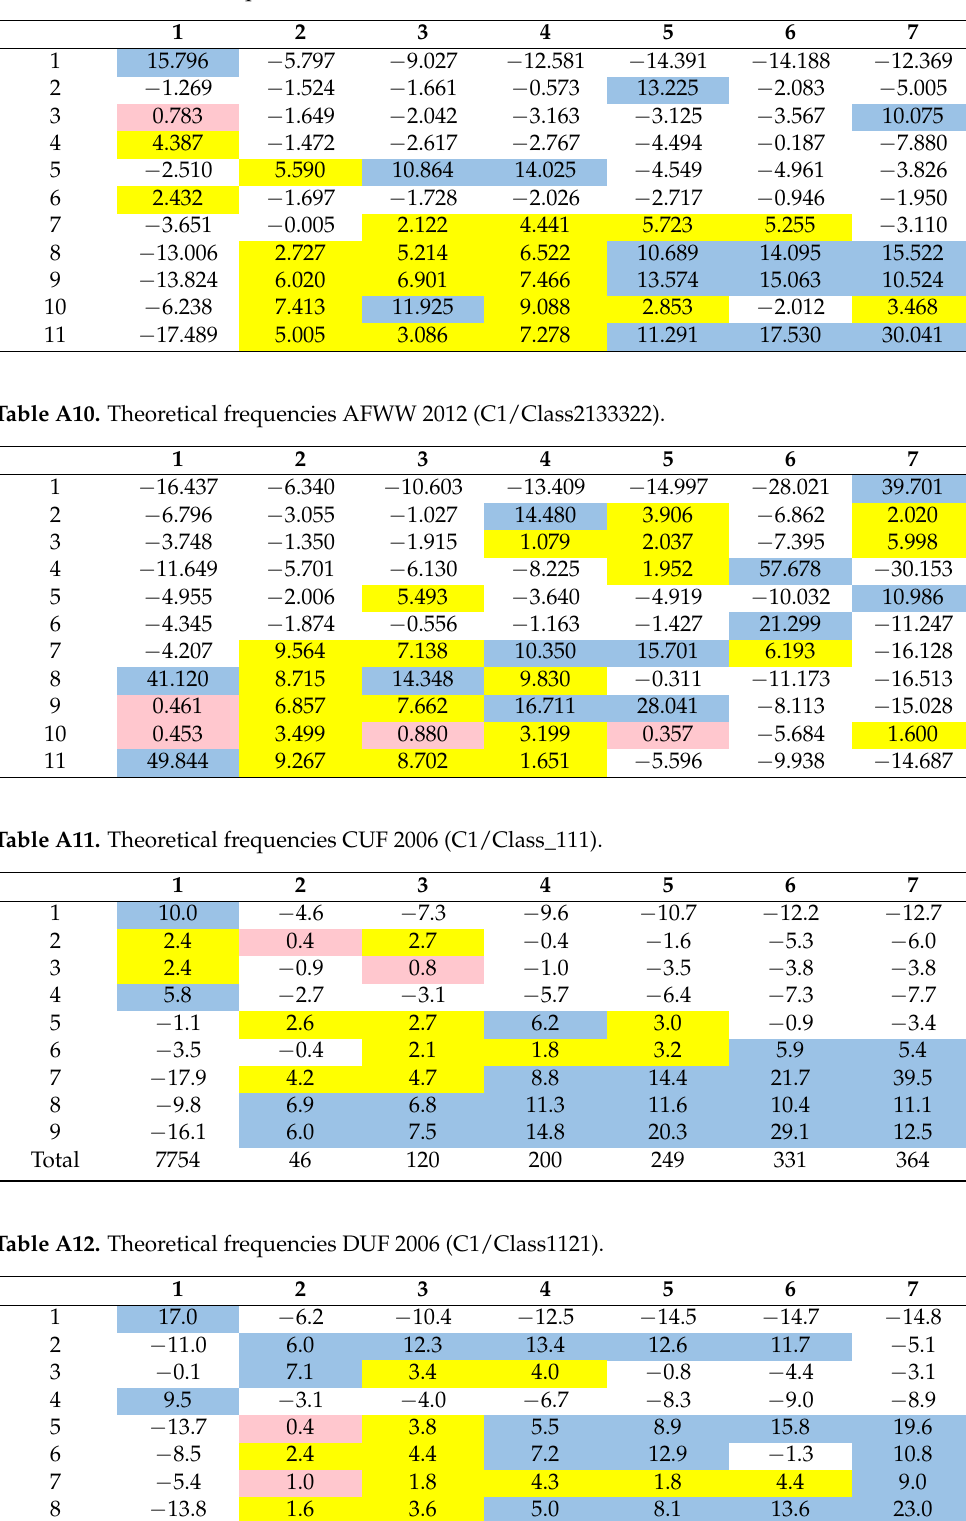
Table A9. Theoretical frequencies IMA 2012 (C1/Class_121142).